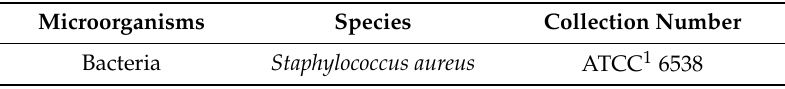
Table 4. Microorganisms used in antimicrobial